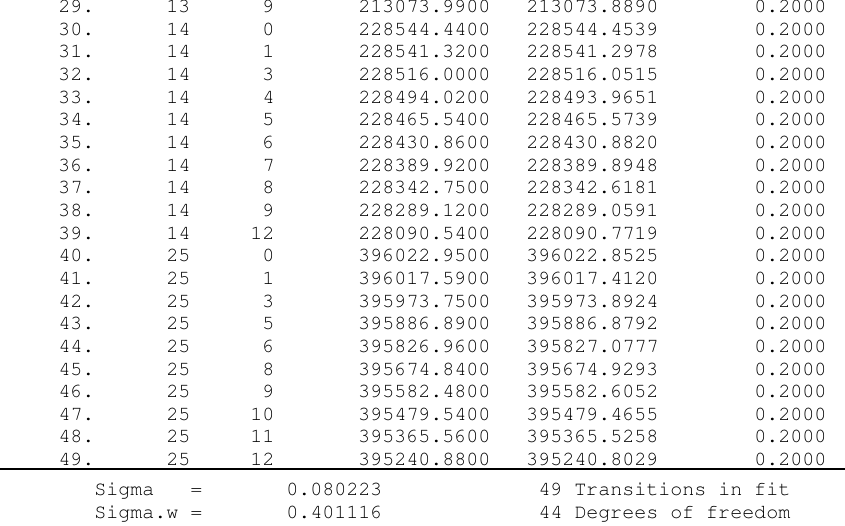
CN, CD 313 CN and CD 3